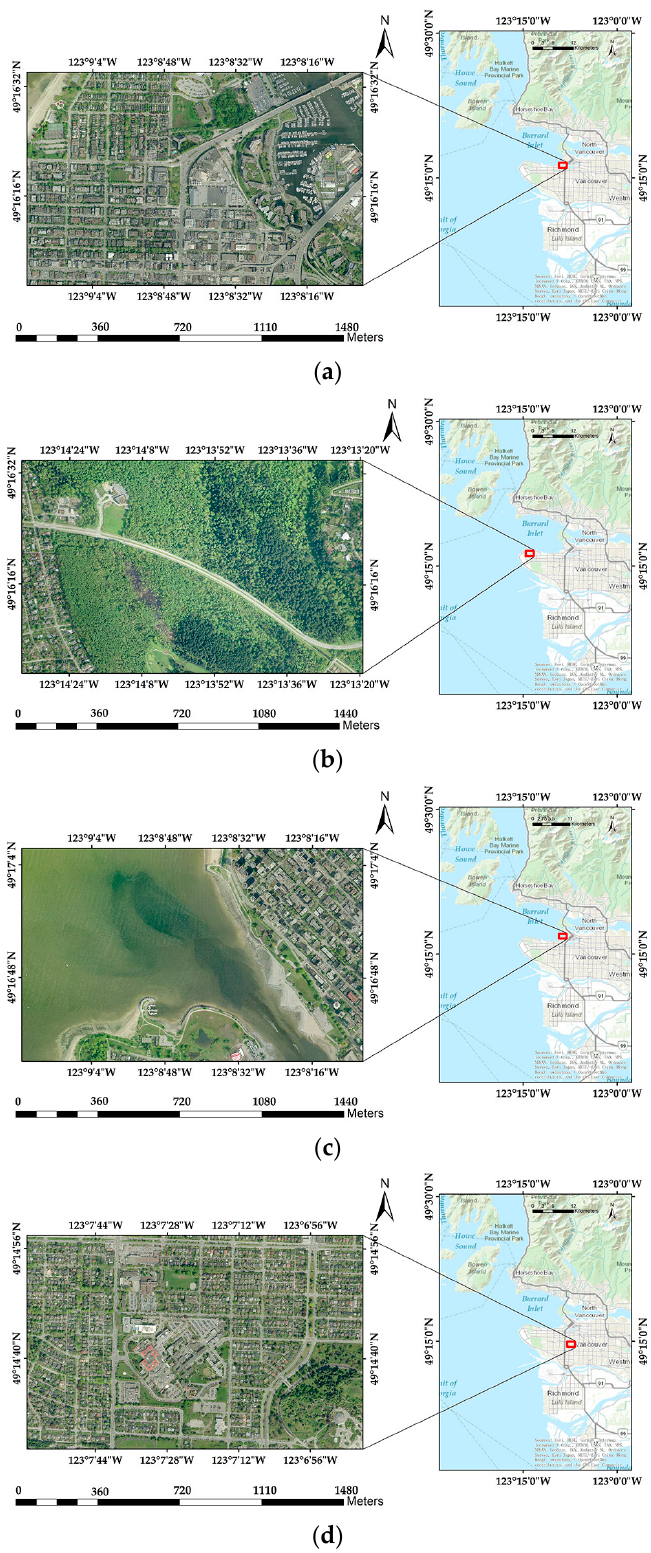
Figure 9. Parts of experimental data: ( a – d ) are remote sensing images of Vancouver.